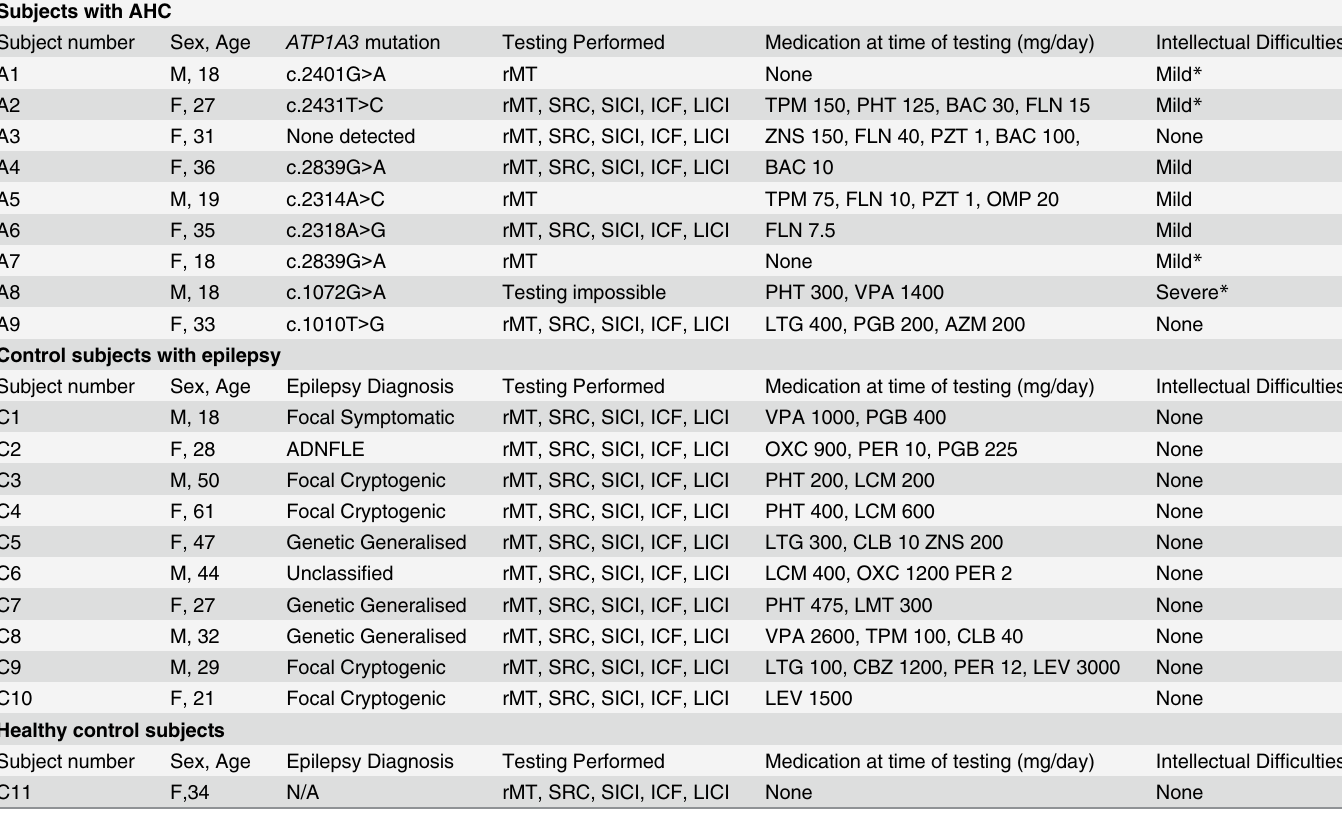
Table 1. Age, sex, mutation (subjects with AHC only), epilepsy diagnosis (epilepsy control subjects only), TMS paradigms tested, medication at time of testing and degree of intellectual difficulties for all subjects. Subjects with